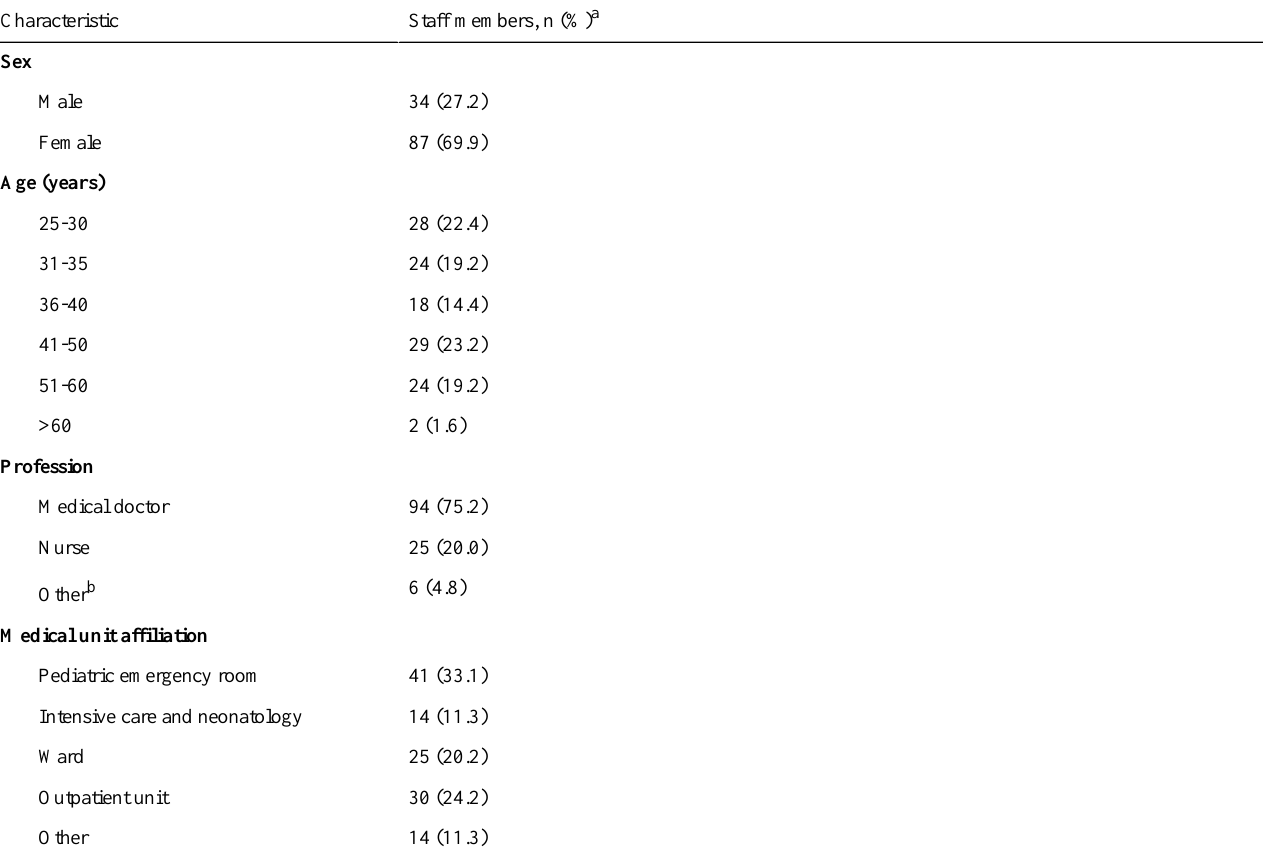
Table 1. Demographic characteristics of hospital staff (N=125).